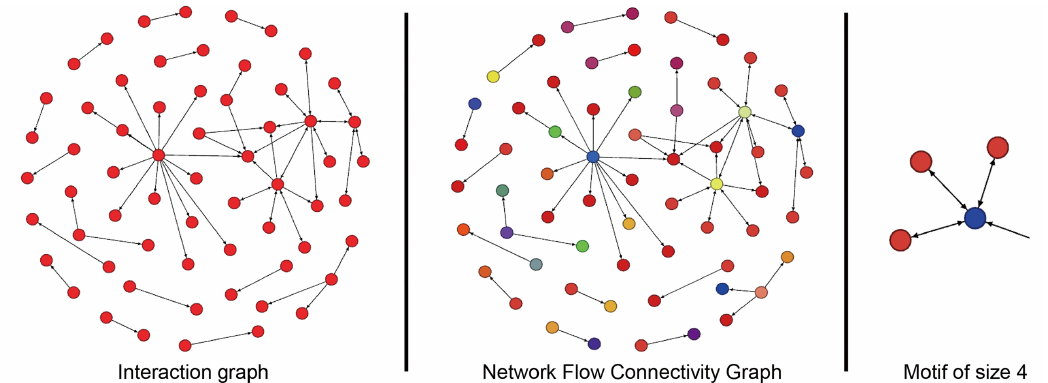
Figure 3. Visualization example of interaction graph, NFCG and motif. The interaction graph consists of 64 nodes, with each edge representing the interaction relationships between different nodes. The NFCG graph is an augmented interaction graph that can be encoded with supplementary flow information, with each node denoted by a different color/style edge, while the motif is a reoccurring subgraph of the NFCG